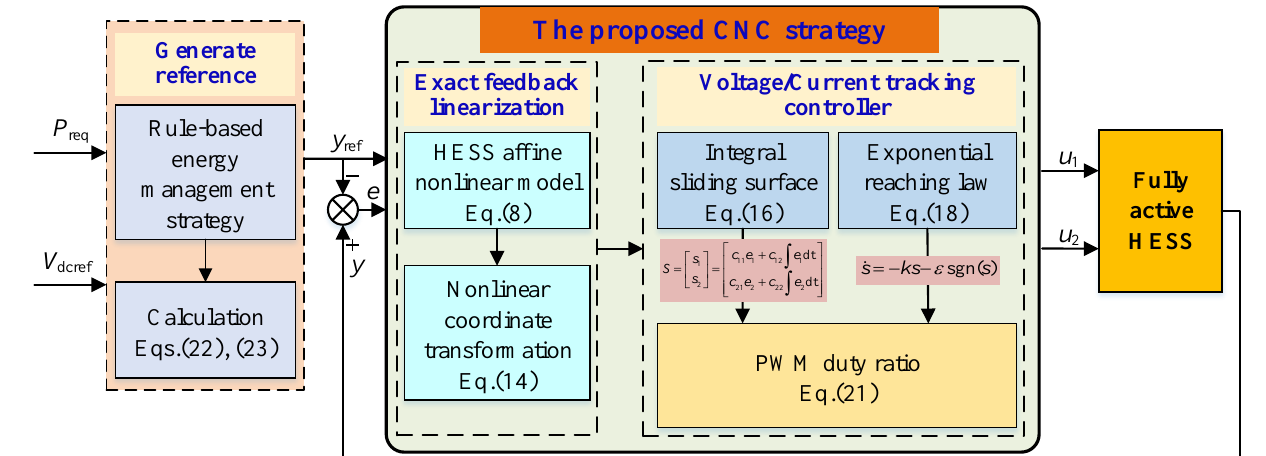
Figure 3. The overall diagram of the proposed composite non-linear control (CNC) strategy.